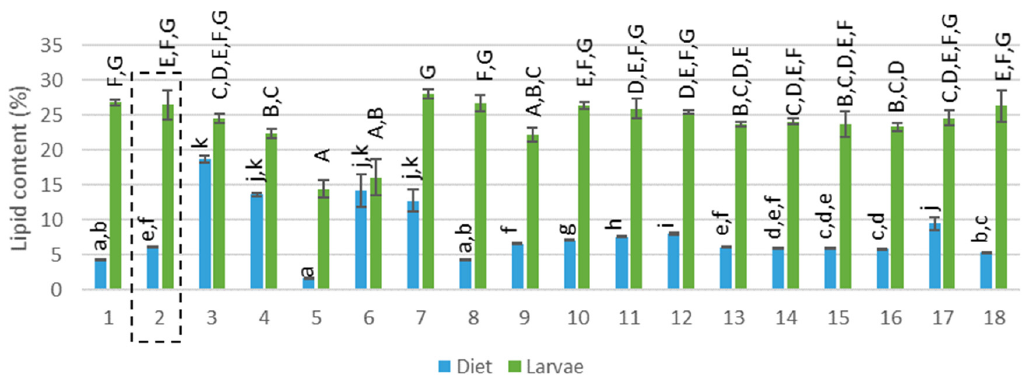
Figure 2. Lipid content (% on dry matter basis) of the diet and corresponding larvae. Diet 2 (reference diet) is framed, capital letters represent the pairwise comparison after the Kruskal–Wallis analysis performed on the lipid content of the larvae while regular letters represent the pairwise comparison after the Kruskal–Wallis analysis performed in the lipid content of the diets.